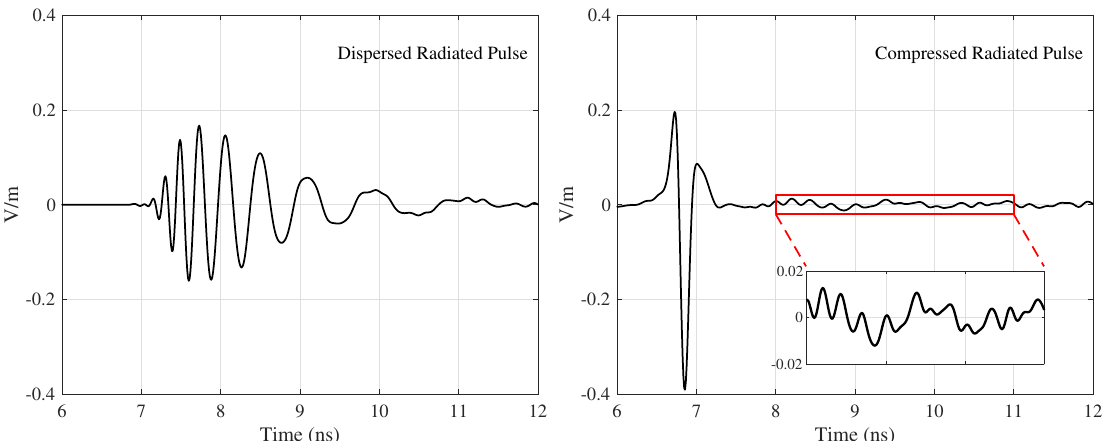
Figure 16. Dispersed radiated pulse at 2 m ( left ), and the corrected radiated pulse at 2 m after the dispersion model has been applied ( right ) for the traditional sinuous antenna with resonances. Note that the dispersion model does not compensate for the late-time ringing due to the unintended resonant modes.